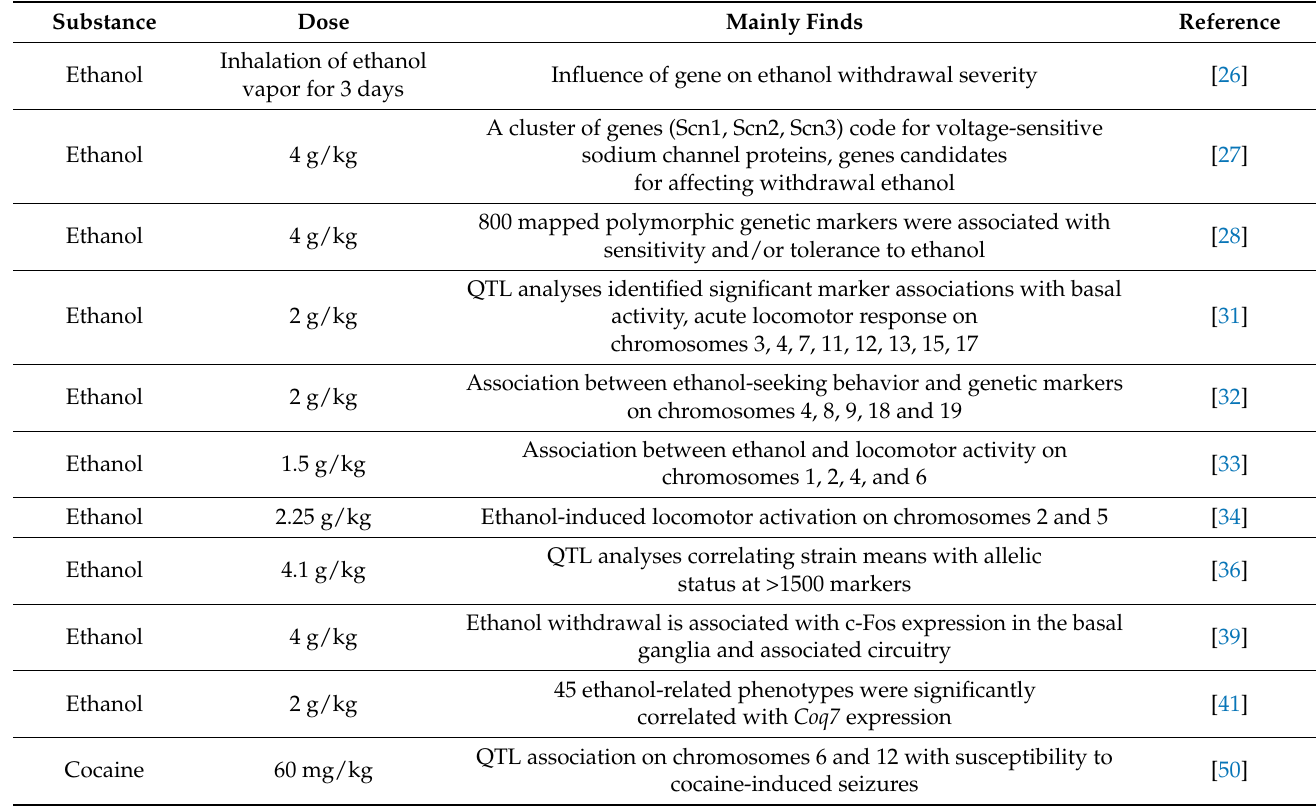
Table 1. An overview of the use of BXD RI strain in studies of the neurotoxicity in response to ethanol, cocaine, metals and pesticide